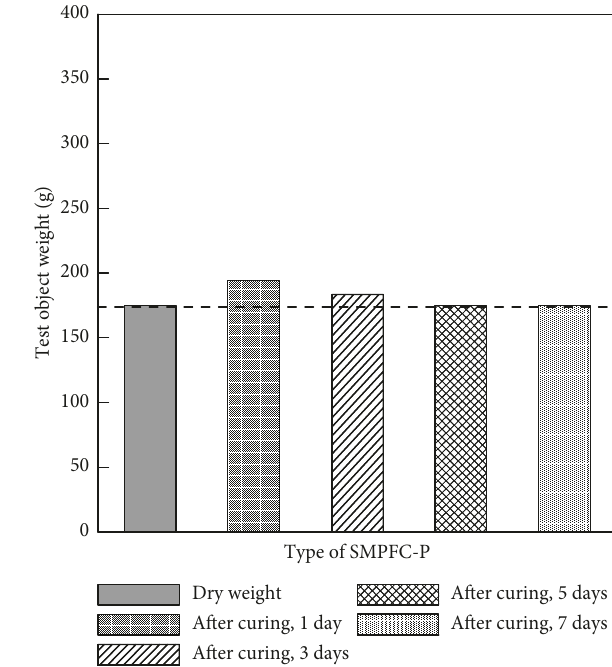
Figure 10: Test results of moisture content